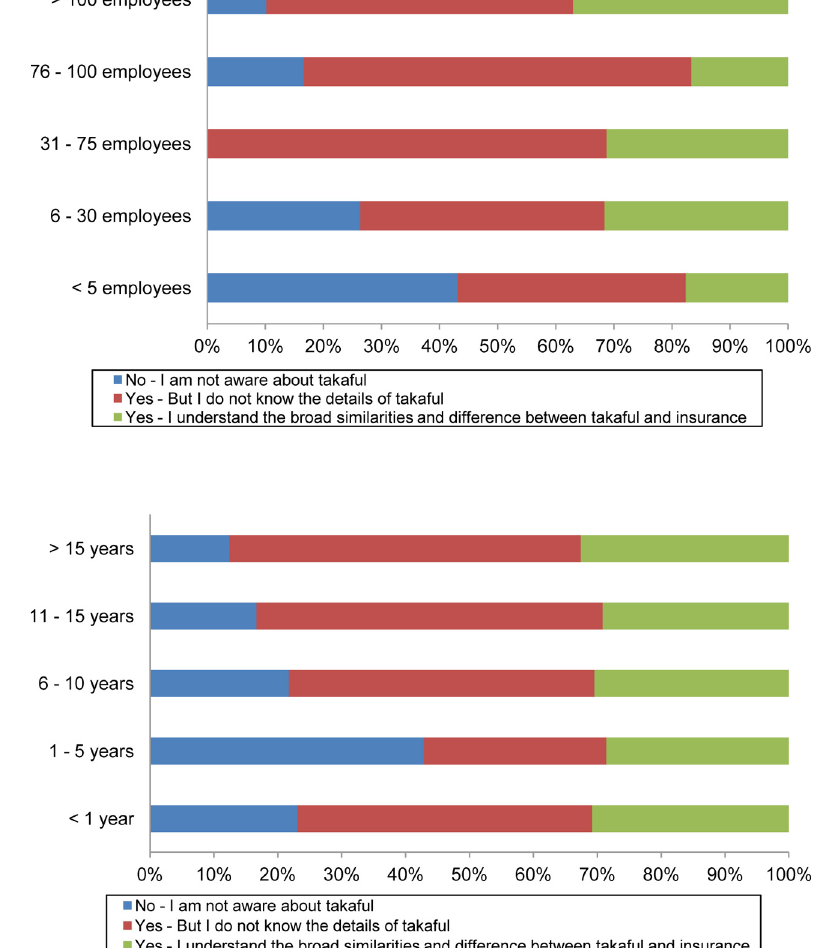
Figure 7. Composition